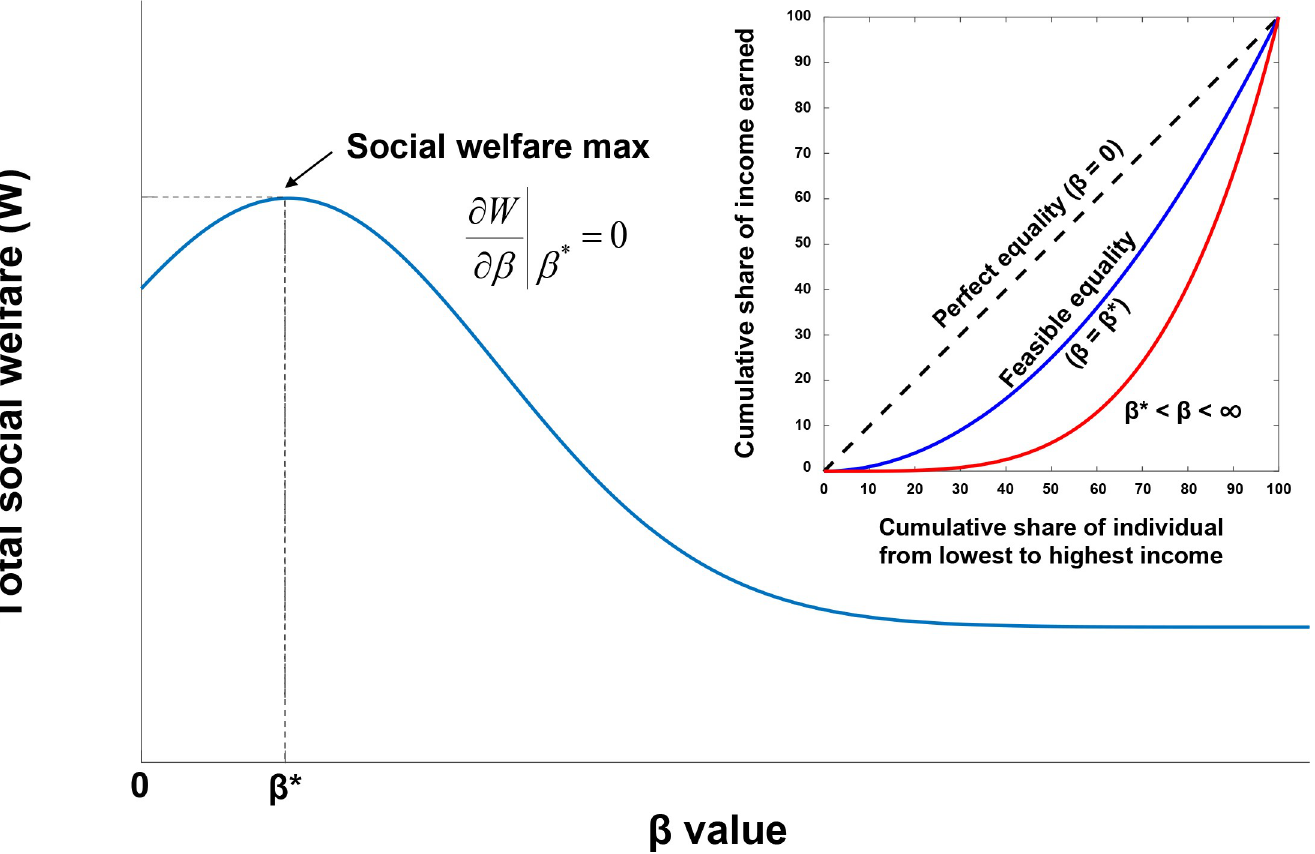
Fig 3. Total social welfare as a function of β value. The welfare function is maximized at β = β � , and the corresponding Lorenz curve (blue) represents the feasible equality line (the optimal income distribution).